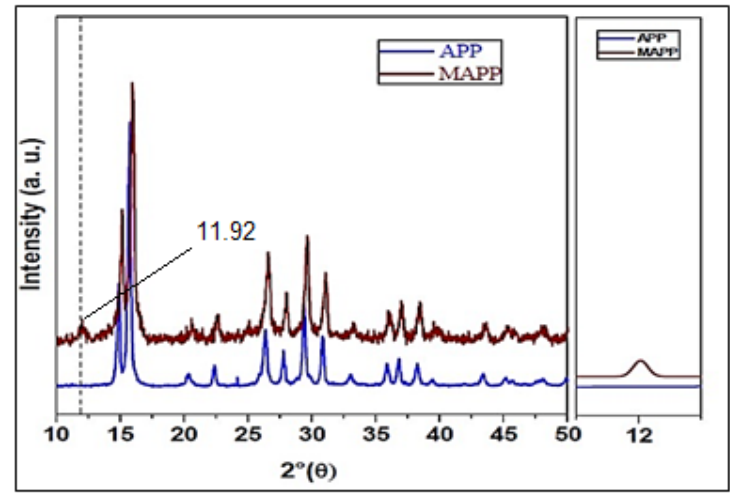
Figure 2. The XRD curves of APP and MAPP.